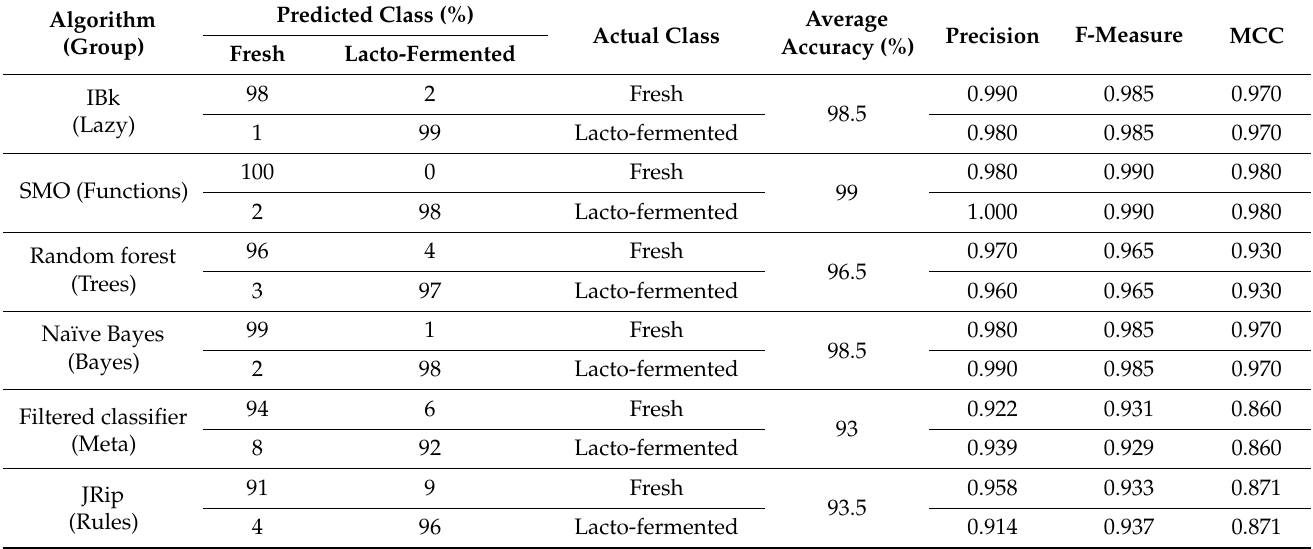
Table 4. The discrimination of fresh and lacto-fermented red bell pepper samples based on models developed using selected image textures from color space RGB.